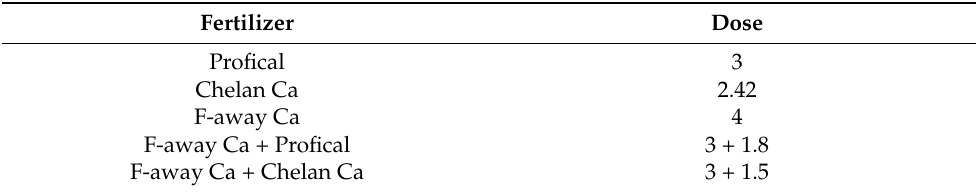
Table 2. Fertilizer doses (L t − 1